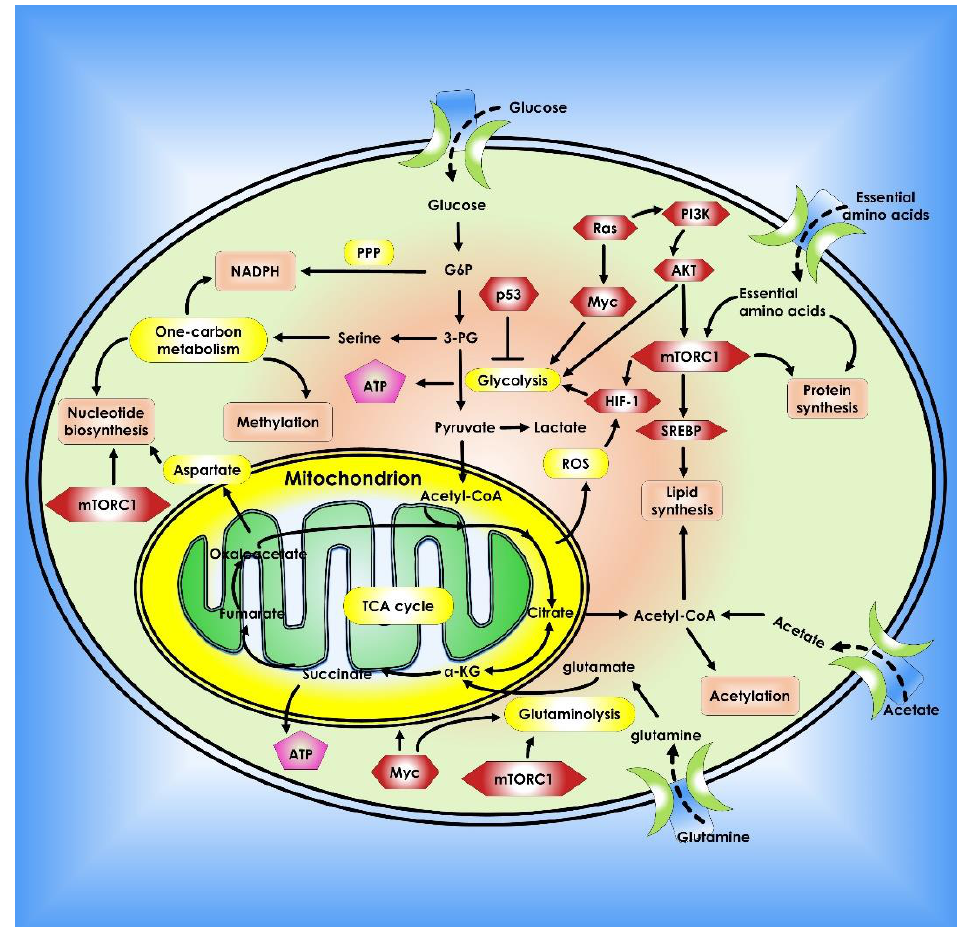
Figure 1. Metabolic pathways that control cancer’s ability to grow and spread. Nucleotide, protein, and lipid synthesis are induced by abnormal activation of mTORC1 in tumor cells. Further anabolism is promoted when tumor suppressors like p53 are lost, or oncogenes are activated. Regulation of ROS, acetylation, and methylation by metabolism is one way that metabolic signaling is kept under control.